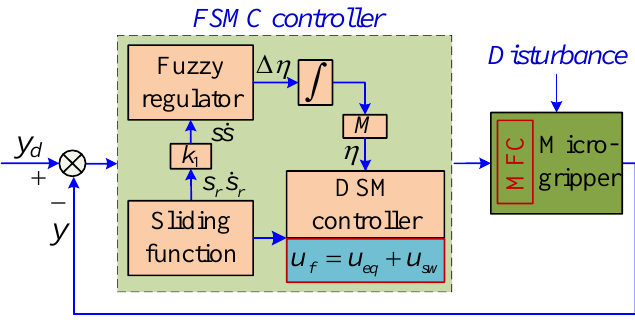
Figure 4. Schematic diagram of the trajectory controller.